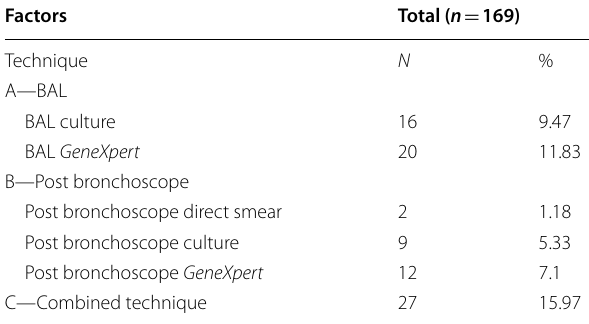
Table 2 Diagnostic yield of fiber‑optic bronchoscopic